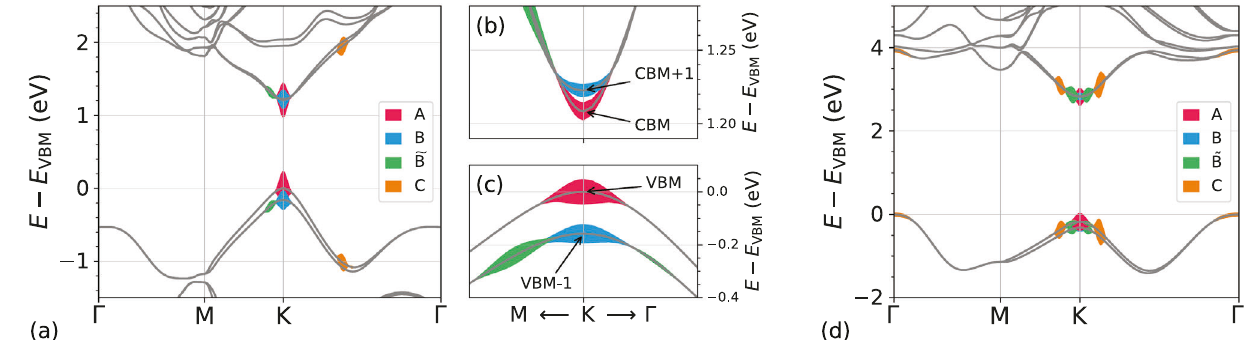
Fig. 4 Weighted band structures. G 0 W 0 bandstructure of a MoSi 2 P 4 and d MoSi 2 N 4 with weights of the single-particle transitions giving rise to excitons A, B, e B , and C (Fig. 3). In b and c we report details of the CBM( + 1) and VBM( − 1), respectively, around the K